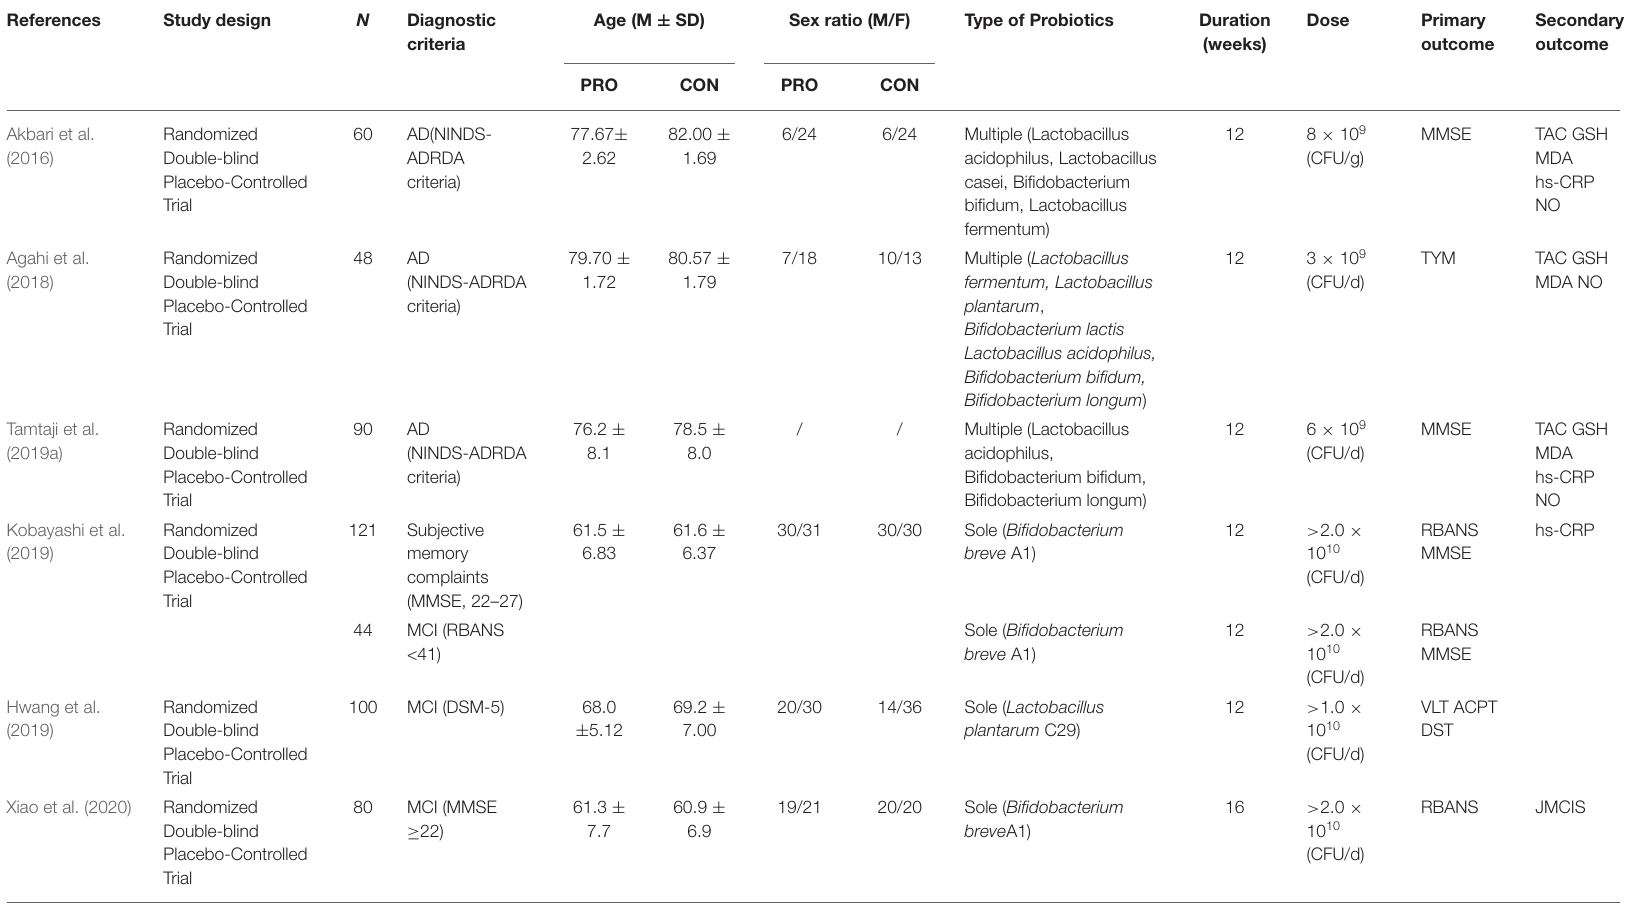
TABLE 1 | Main characteristics of the included AD and MCI